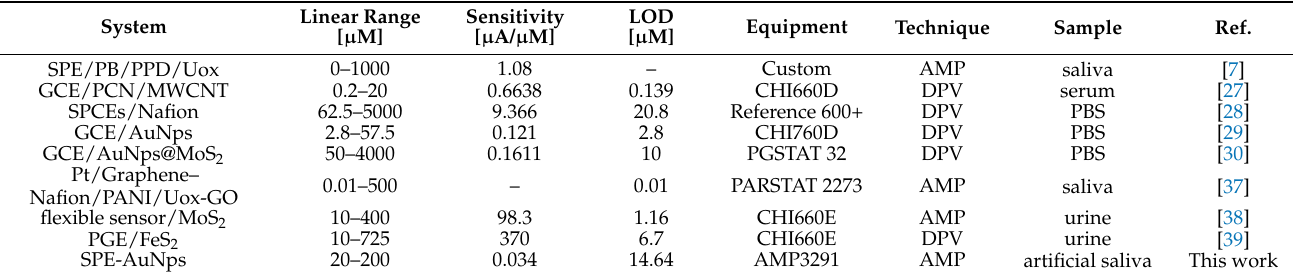
Table 3. Comparison with similar systems for detection of